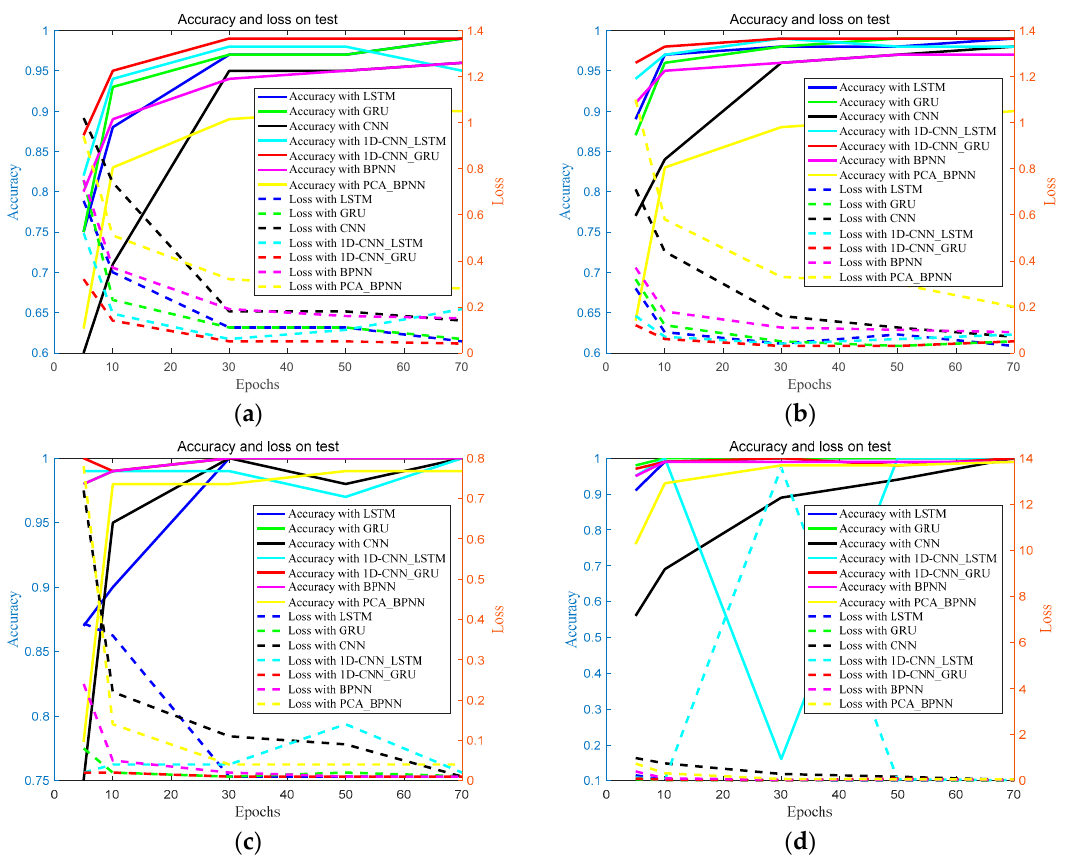
Figure 14. Comparison experimental results with fault severity ( a ) level I, ( b ) level II, ( c ) level III, and ( d ) level IV.